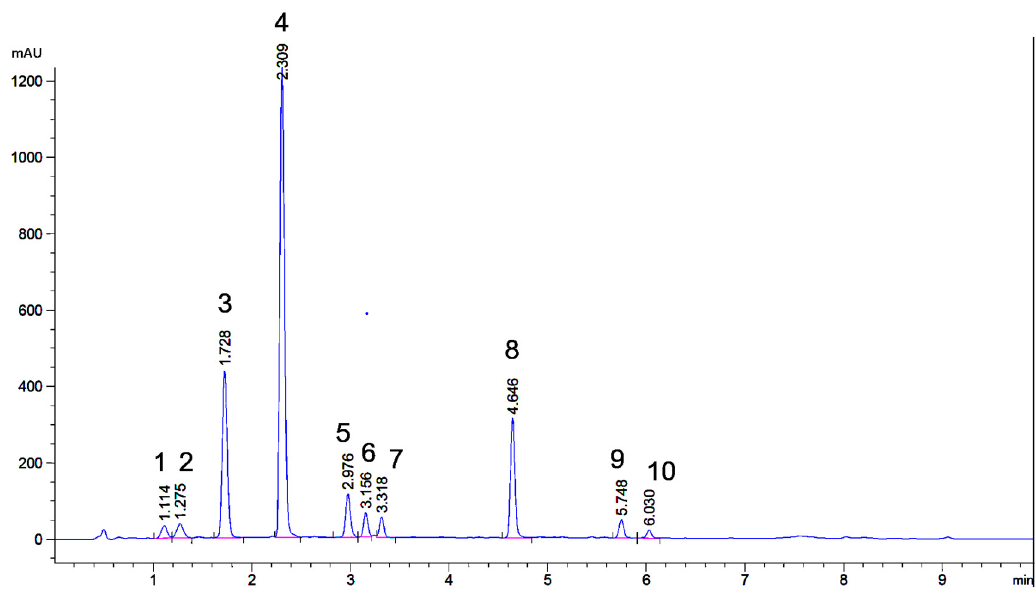
Figure 2. Reversed phase UHPLC profile of an extract of weld; UV detection at 345 nm. Peaks of the ten main flavones are numbered and correspond with the bold numbers in Figure 1.